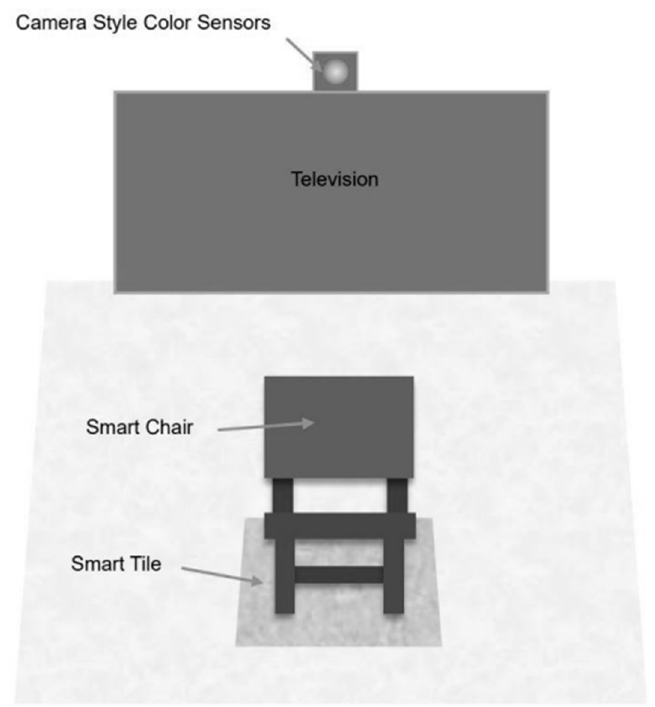
Figure 8. A schematic of smart home construction.